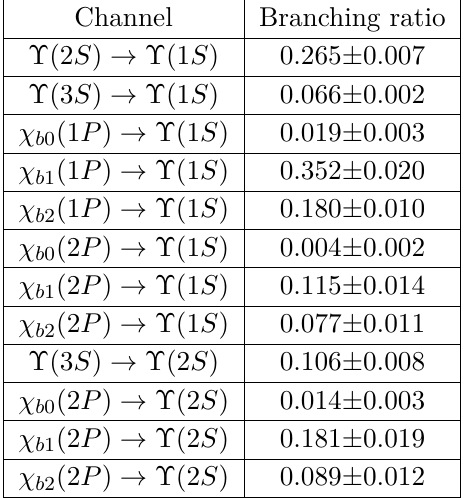
Table 1. Branching ratios of different bottomonium